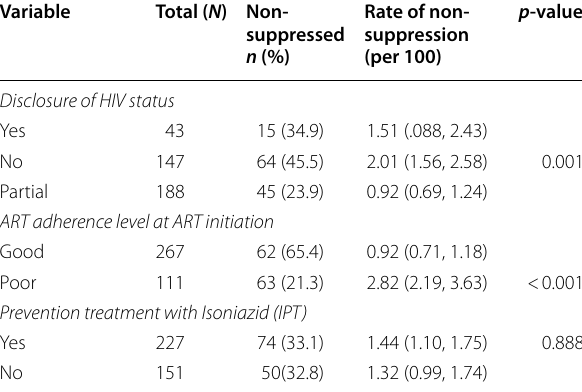
Table 5 Bi-variable and multi-variable analysis for determinants of HIV viral non-suppression among HIV-positive children and adolescents on ART in Tabora region, from January 2018 to